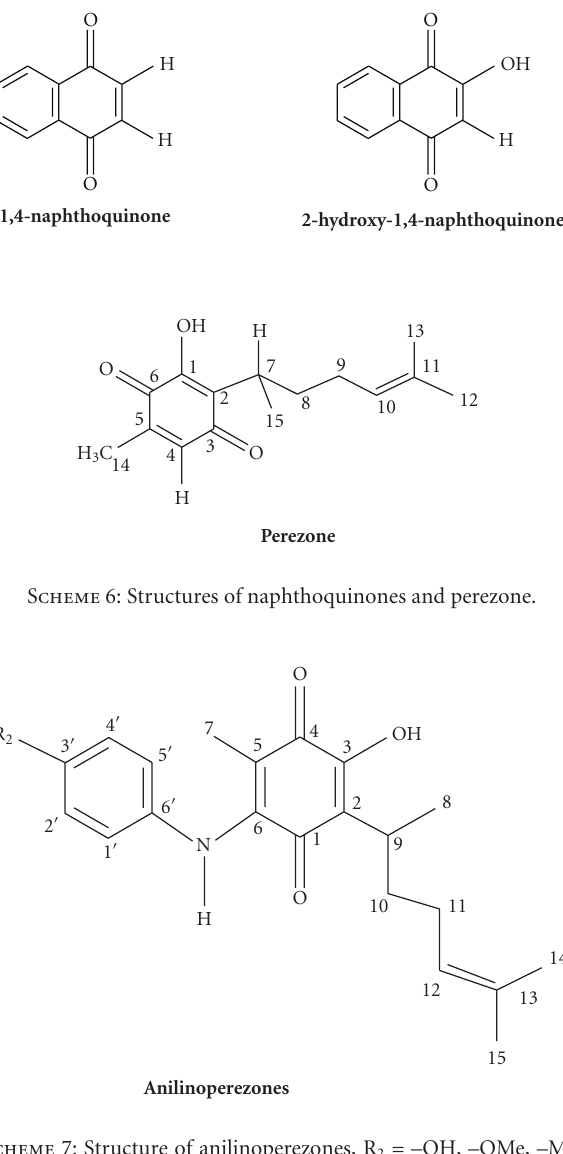
Scheme 7: Structure of anilinoperezones, R 2 = –OH, –OMe, –Me, –Br, and